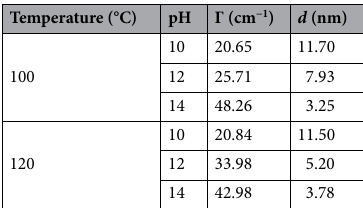
Table 2. Crystallite sizes from Raman spectroscopy.